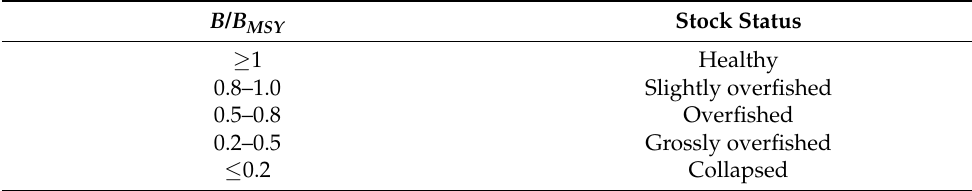
Table 2. Definition of the stock status in the present study based on the values of B / B MSY